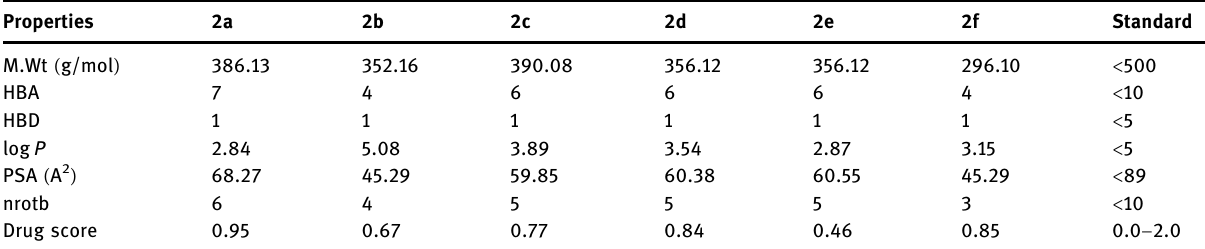
Table 1: Chemo - informatics properties of synthesized compounds 2a – 2f